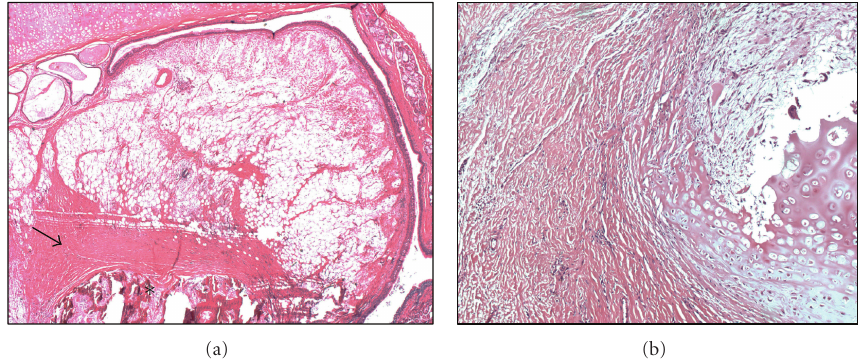
Figure 2: (a) Part of the hamartoma extending polyploidly into the endobronchial lumen with transition in the more spindle-celllike (arrow) and osseous component (star) (HE, 25-fold magnification). (b) Further components of the hamartoma with chondroid parts (B, HE, 100- fold magnification) within a cell-reduced, partly fascilular stroma with a hemangio pericytoma-like vessel